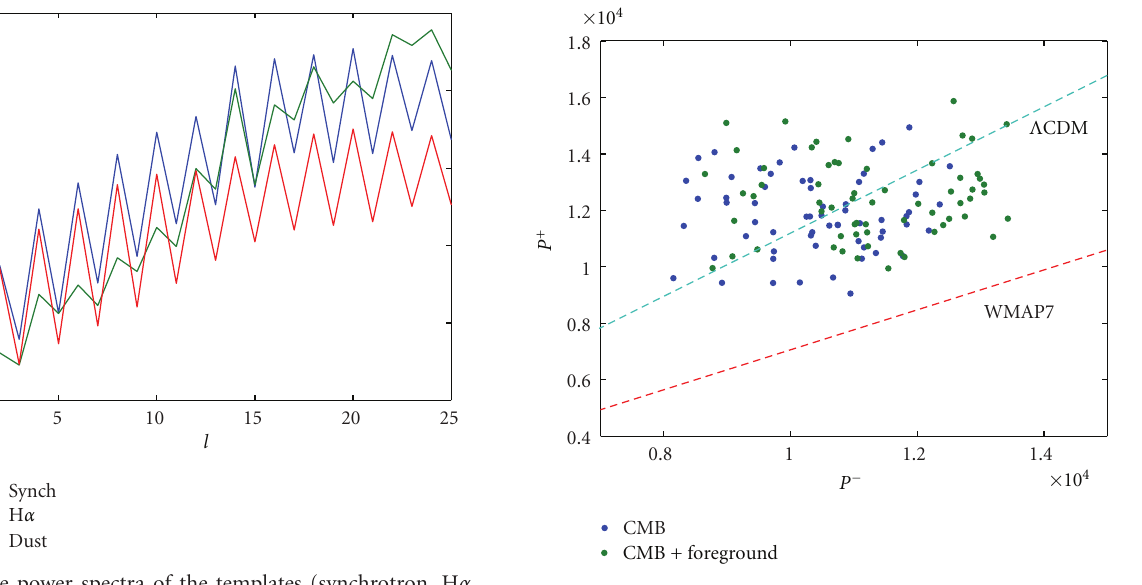
Figure 7: The parity asymmetry in the presence of residual foregrounds (V − W): dashed lines are plotted with slopes corre- sponding to P + /P − of P + /P − of Λ CDM (cyan), WMAP7 data (red).